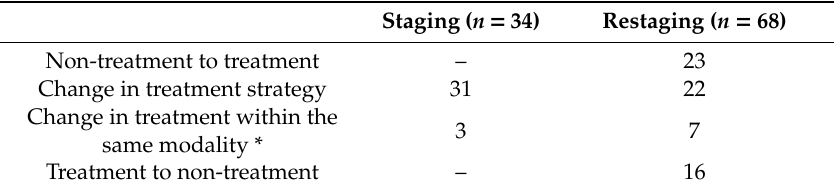
Table 4. Summary of the contributions of 18 F-FDG PET / CT in changing patient